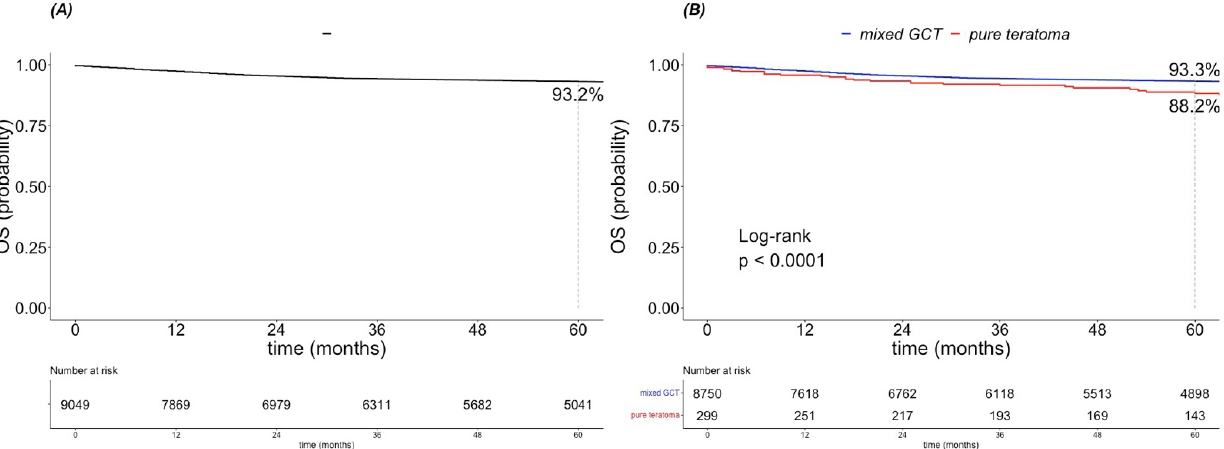
Figure 1. Kaplan–Meier estimates of ( A ) overall survival (OS) in 9183 patients and ( B ) OS after stratification according to pure teratoma vs. mixed germ cell tumor (GCT).